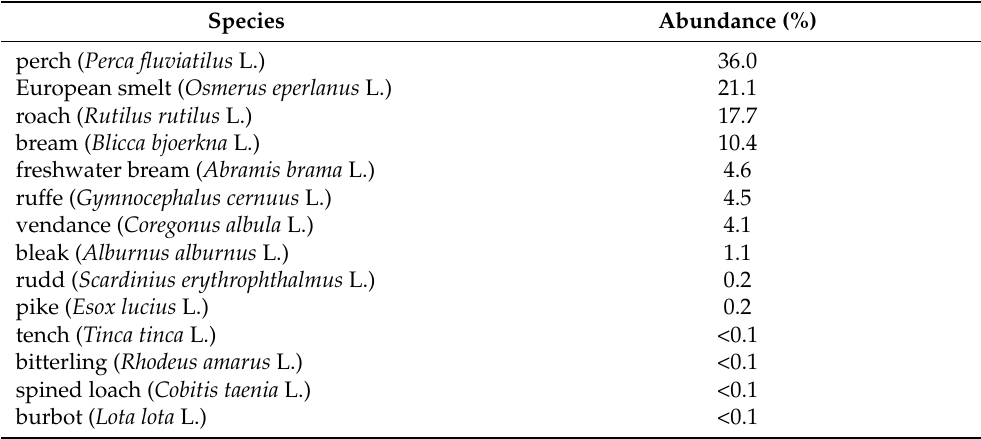
Table 1. List of species and abundance of fish in benthic gillnet fisheries on 27–30 September 2021, in Lake Dejguny.